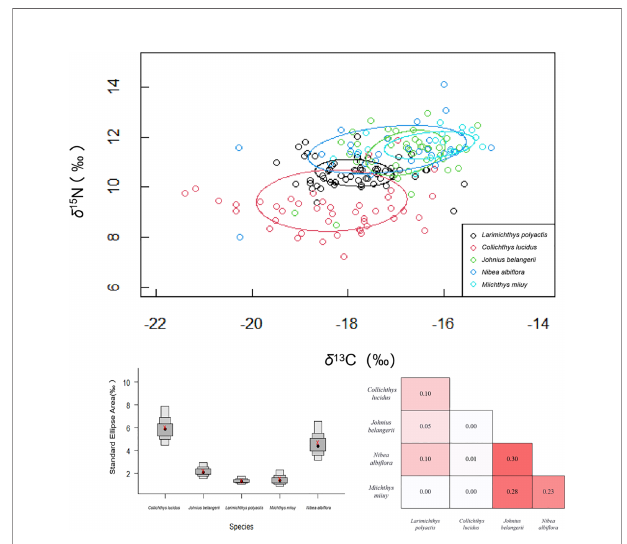
FIGURE 6 | Corrected standard ellipse area (SEAc) representing the trophic niche width of fi ve sciaenid fi sh species collected from the Zhoushan Archipelago between 2019 and 2021. SEAc represents the trophic niche width of fi ve sciaenid fi shes. Overlap (numbers inside boxes) of corrected standard ellipse areas (SEAcs) of sciaenid fi shes estimated using Stable Isotope Bayesian Ellipses (SIBER) in R. Colour intensity increases with SEAc